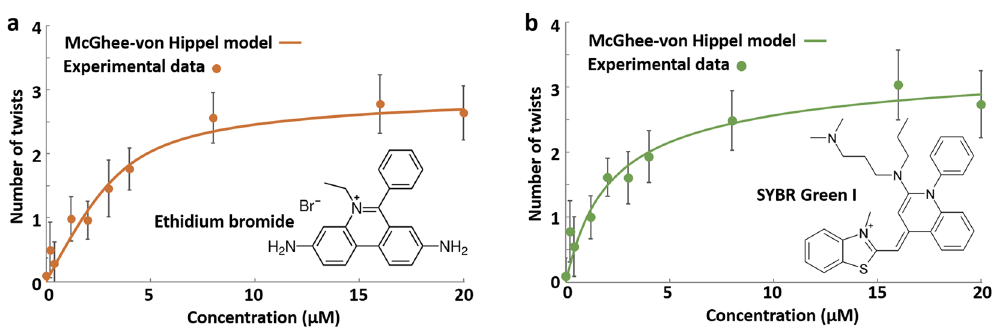
Figure 3. The number of twists in DNA origami nanorails as a function of the intercalator concentration for ( a ) ethidium bromide and ( b ) SYBR Green I. Filled circles are experimental data points and lines are fits using the McGhee-von Hippel model (Supporting Information S6). Error bars represent root-mean-square deviation of the data from the